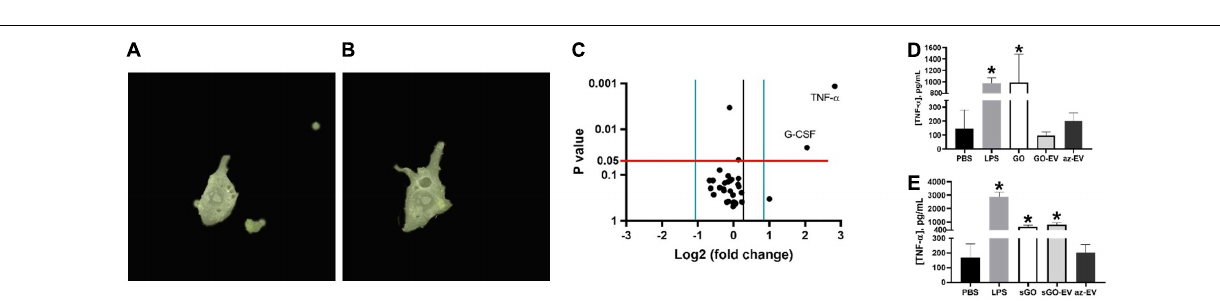
FIGURE 5 | GO-EV does not induce DNA damage. HL-60 cells were treated with PBS (control), 4 µ g/ml GO-EV or sGO-EV for 24 h, or 20 µ m etoposide (positive control) for 1 h. An alkaline-based comet assay was performed at the treatment end point to assess for the presence of DNA breaks. Images of the DNA tails were captured by fluorescence microscopy (A) and the average tail length (B,C) was calculated for each treatment condition using the OpenComet software. The lines mark the average DNA tail length for each population.